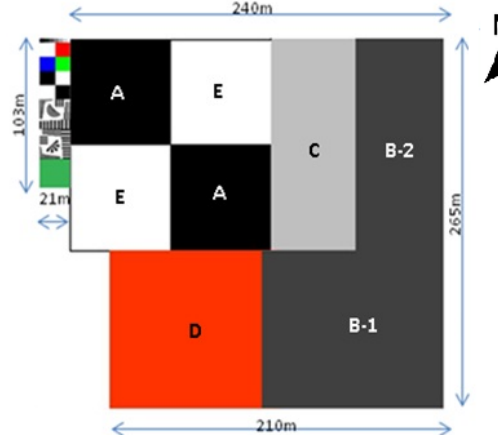
Figure 2. Final design layout of the calibration site. On the left hand side targets for very high resolution are also seen.